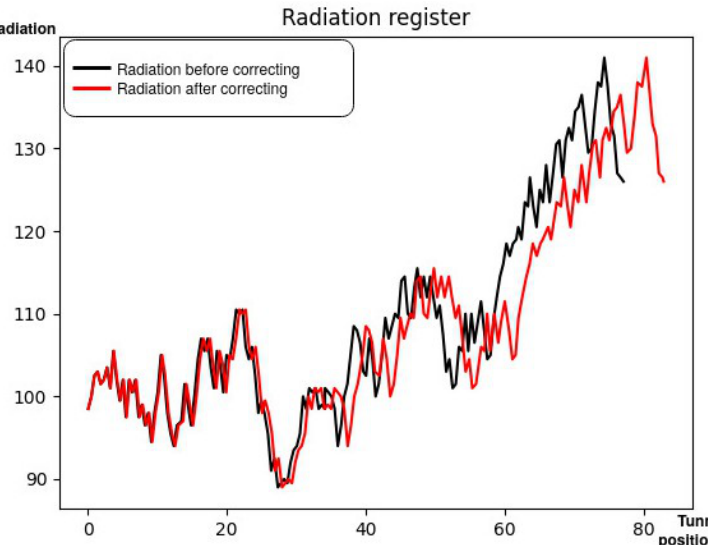
Figure 10. The radiation registered during a survey. The black line represents the radiation related to the position estimation by EKF, while the red line represents the radiation related to the position estimation by GGO, after finding a sector door at 82.81 m from the